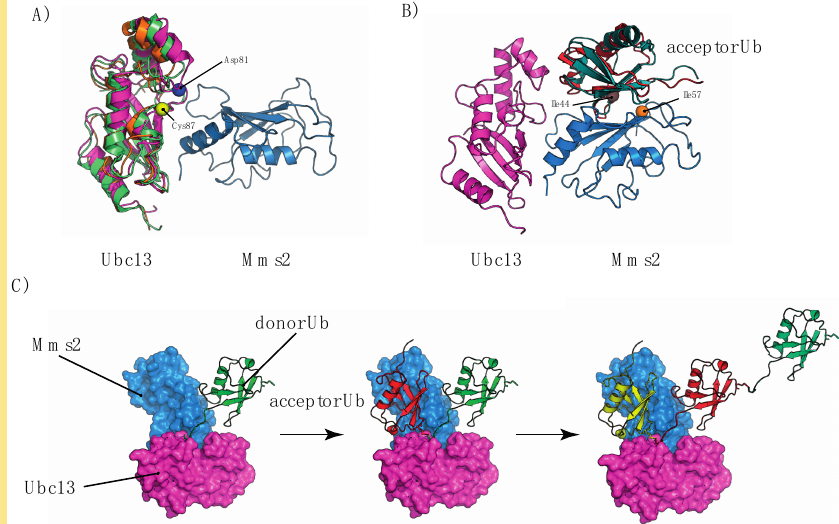
Figure I. Superimposition of several structure of the Mms2/Ubc13 complex ( A ), aligned on the Mms2 structure (PDB codes: 2GMI: pink, 1JAT: green, 1J7D: orange). ( B ) Structure of the Mms2/Ubc13/Ub acceptor complex (1ZGU: red, 2GMI: green). ( C ) Model of Lys63-linked polyUb chain formation based on the PDB code 2GMI, with a Ub donor molecule delivered to the Mms2/Ubc13 complex (green) by E1. An acceptor Ub then binds to the acceptor binding site of the Mms2/Ubc13 complex, allowing Lys63 to form an isopeptide bond with the donor Ub. The previous donor Ub (green) then becomes the acceptor Ub, and a new donor Ub is loaded by another